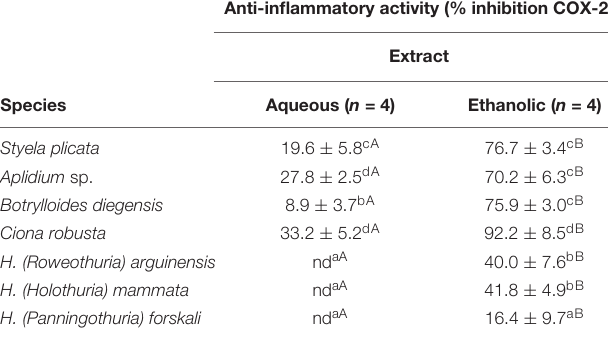
TABLE 3 | Anti-inflammatory activity (% inhibition of COX-2) in aqueous and ethanolic extracts of the studied tunicates and sea cucumber species. Anti-inflammatory activity (% inhibition